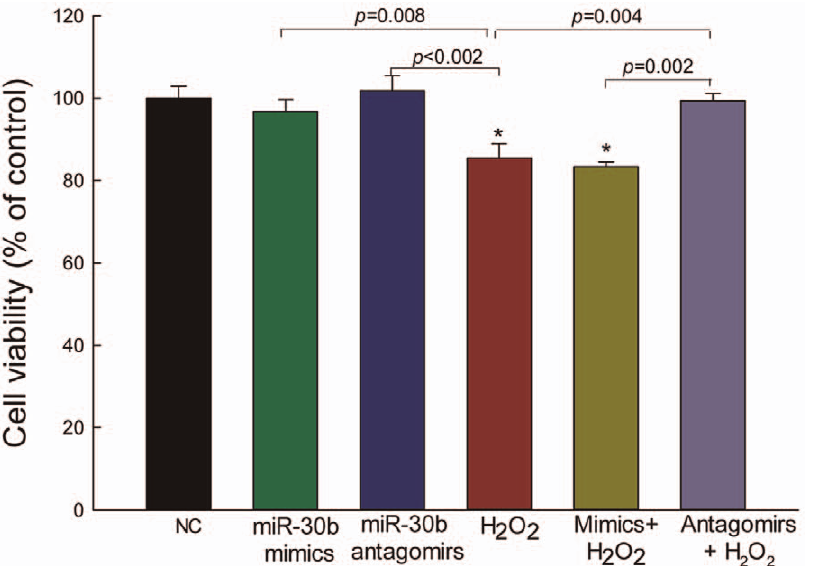
Figure 3. Effect of mimics and antagomirs on cell viability assessed by CellTiter-Blue in ARPE-19. ARPE-19 cells were transfected with mimics (20 nM) and antagomirs (50 nM) in presence or absence of H 2 O 2 treatment, and incubated for 24 h before adding the CellTiter-Blue reagents; H 2 O 2 (200 m M) was added for the last 18 h. NC (20 nM) and H 2 O 2 (200 m M) alone were also used as controls. Data were analyzed using analysis of variance (ANOVA) with Student–Newman–Keuls multiple comparison tests and are expressed as a percentage of the untreated control. The CellTiter- Blue values as labeled by an asterisk are significantly different from the control ( p , 0.05). Values are presented as mean 6 SEM; n=5 per group.